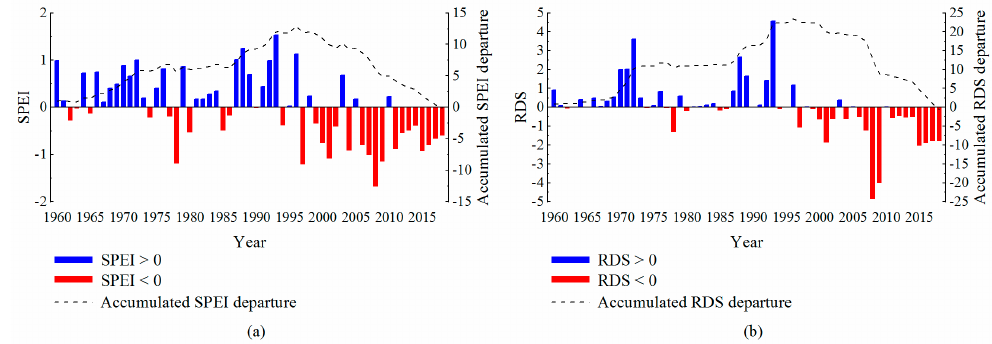
Figure 3. Change characteristics of the SPEI values ( a ) and the RDS values ( b ), over the years in plant growing season. growing